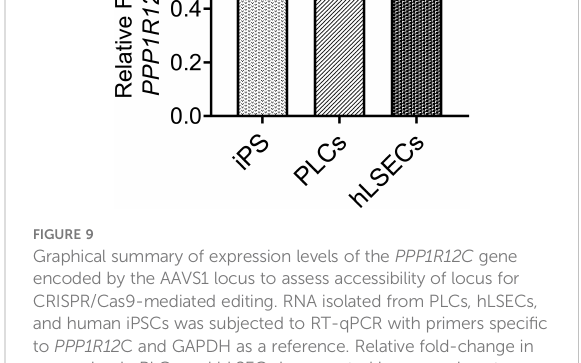
FIGURE 9 Graphical summary of expression levels of the PPP1R12C gene encoded by the AAVS1 locus to assess accessibility of locus for CRISPR/Cas9-mediated editing. RNA isolated from PLCs, hLSECs, and human iPSCs was subjected to RT-qPCR with primers speci fi c to PPP1R12 C and GAPDH as a reference. Relative fold-change in expression in PLCs and hLSECs is presented in comparison to human iPS cells after normalization with GAPDH as the housekeeping gene (n=3 for each cell type). Data are presented as mean plus/minus SEM; **p<0.01. ns, Not-signi fi cant.